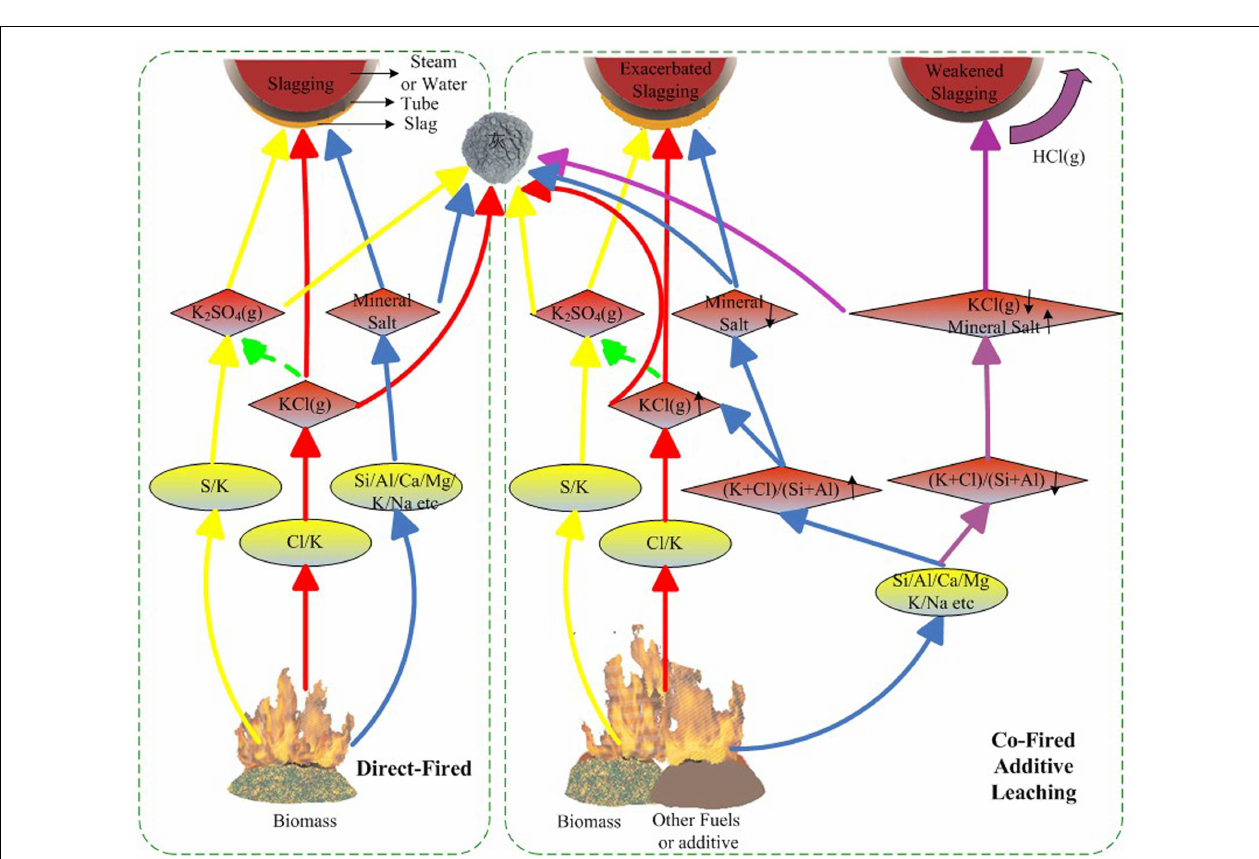
FIGURE 1 | Schematic diagram of the slagging mechanism in biomass-fired furnaces